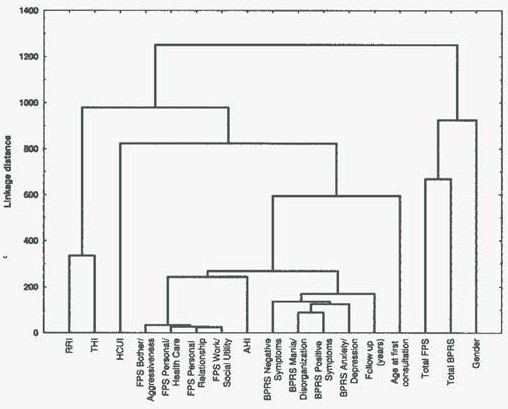
Cluster Analysis.